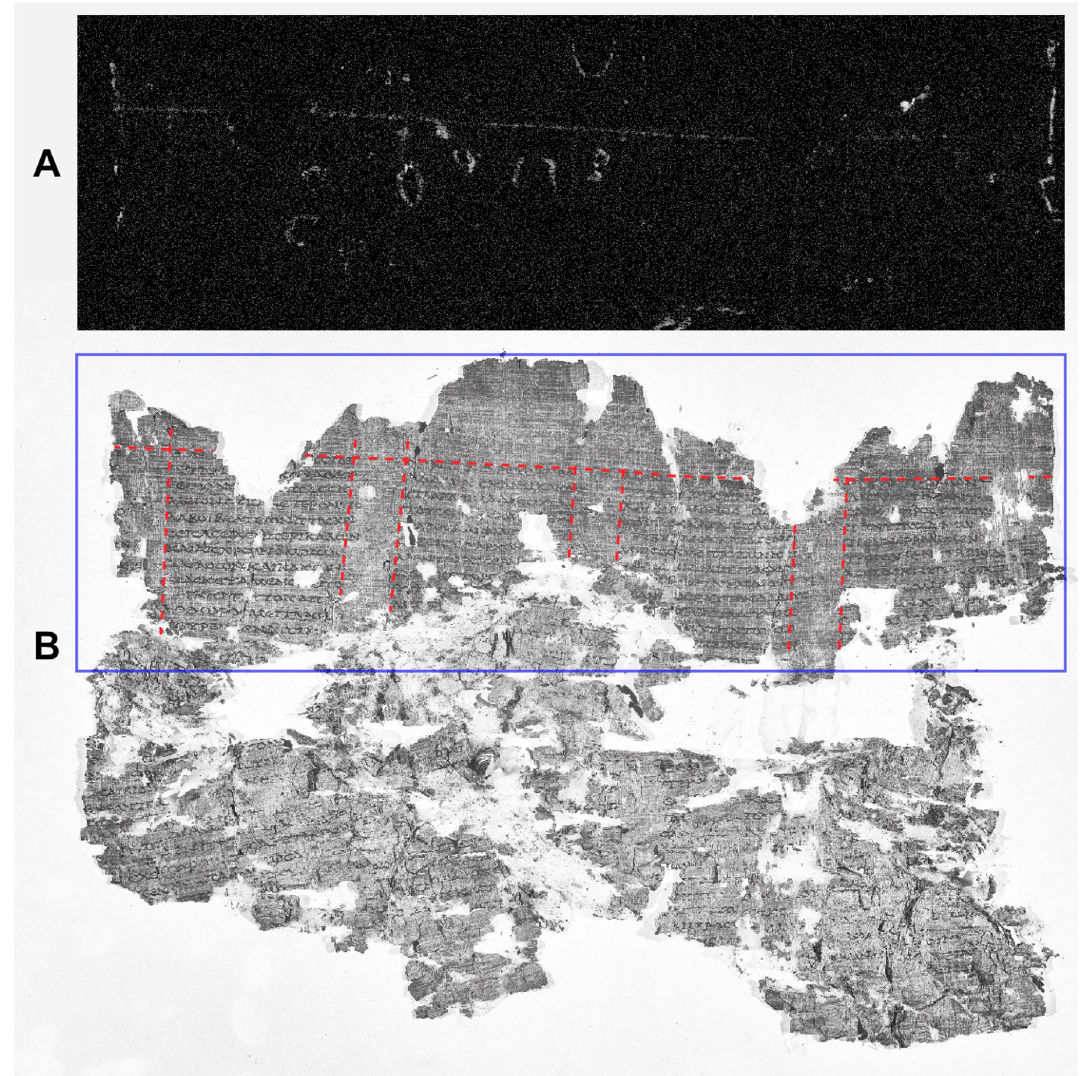
Figure 2. PHerc. 1018, ‘cornice’ 1. Pb distribution map obtained by MA-XRF scanning. By permission of the Ministero della Cultura (photo credit: Biblioteca Nazionale “Vittorio Emanuele III,”